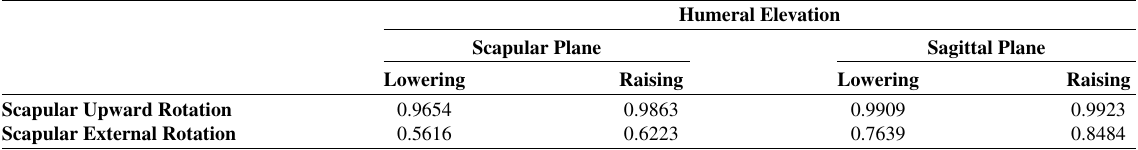
Table 3 Correlation coefficients for collected data compared to results reported in [22]